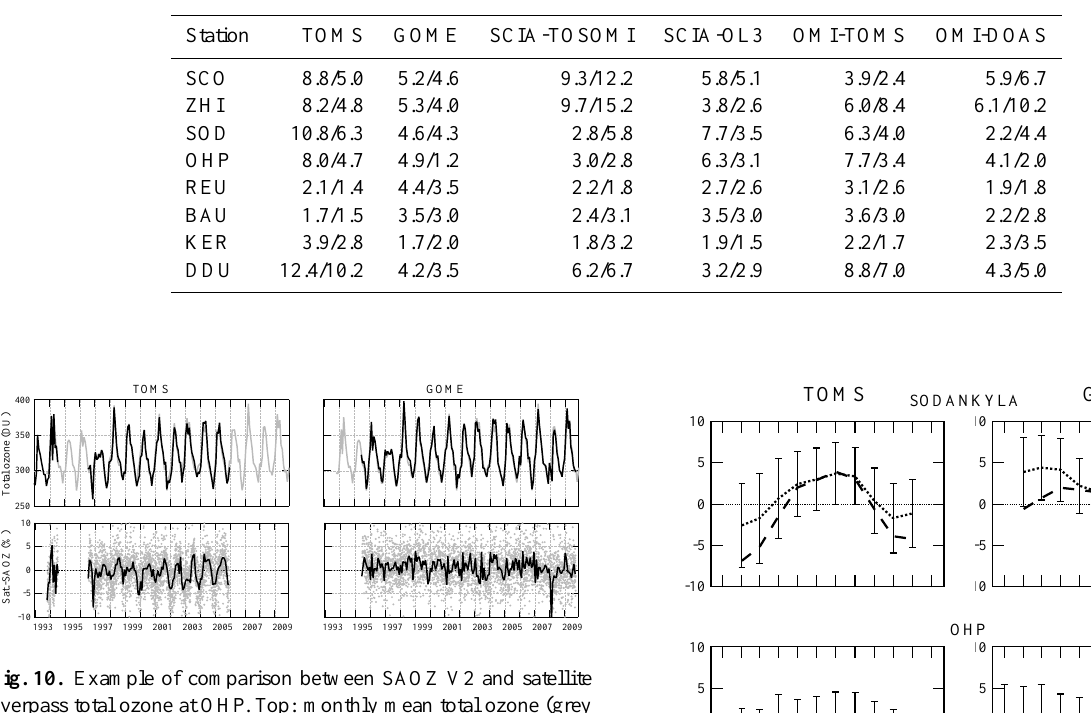
Table 6. Amplitude (%) of the seasonal cycle of the relative differences satellite – SAOZ (V1/V2). See Table 5 for the meaning of the abbreviations of the stations.